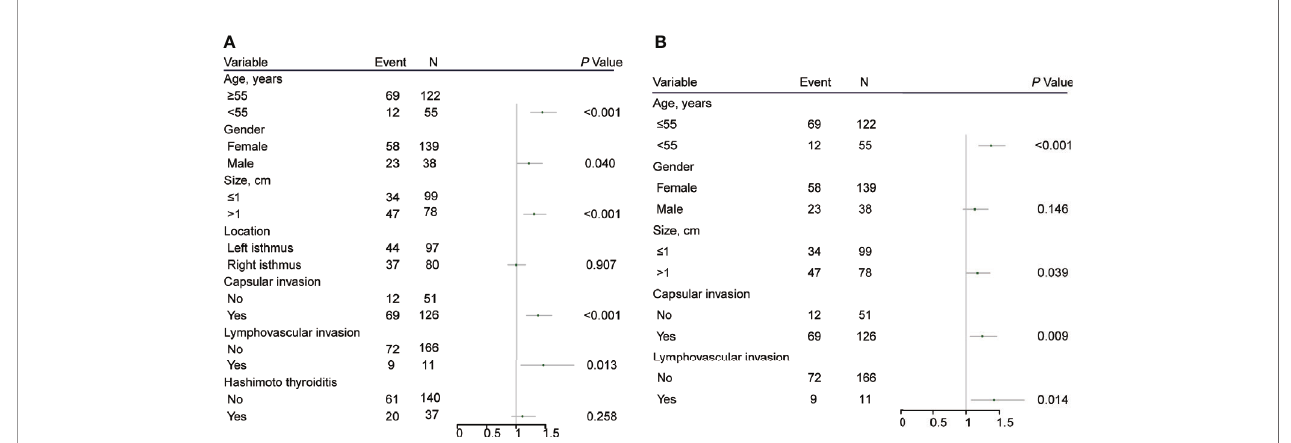
FIGURE 4 | (A) Univariate logistic regression analysis of clinicopathological factors associated with CLN metastasis for patients underwent thyroidectomy with BCLND. (B) Multivariate logistic regression analysis of clinicopathological factors associated with CLN metastasis for patients underwent thyroidectomy with